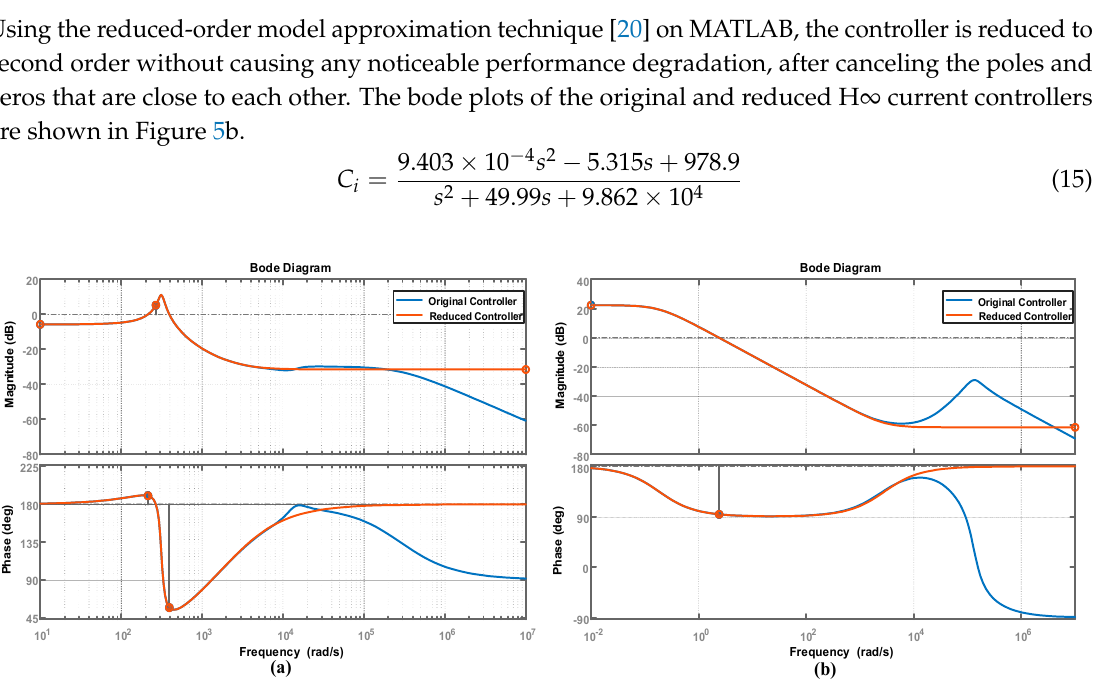
Figure 5. ( a ) Bode plot of the H ∞ voltage controller, ( b ) H ∞ current controller.